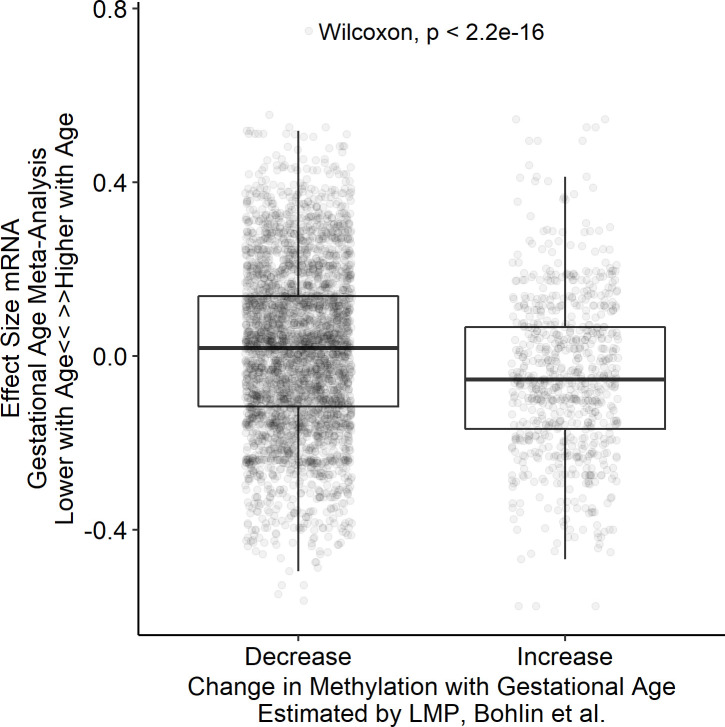
Association between differentially methylated genes and gene expression changes with gestational age.Comparison of effect size associated with gestational age for genes that were reported as differentially methylated by Bohlin et al., 2016. Gene with increased methylation associated with gestational age demonstrate reduced expression with increasing gestational age.